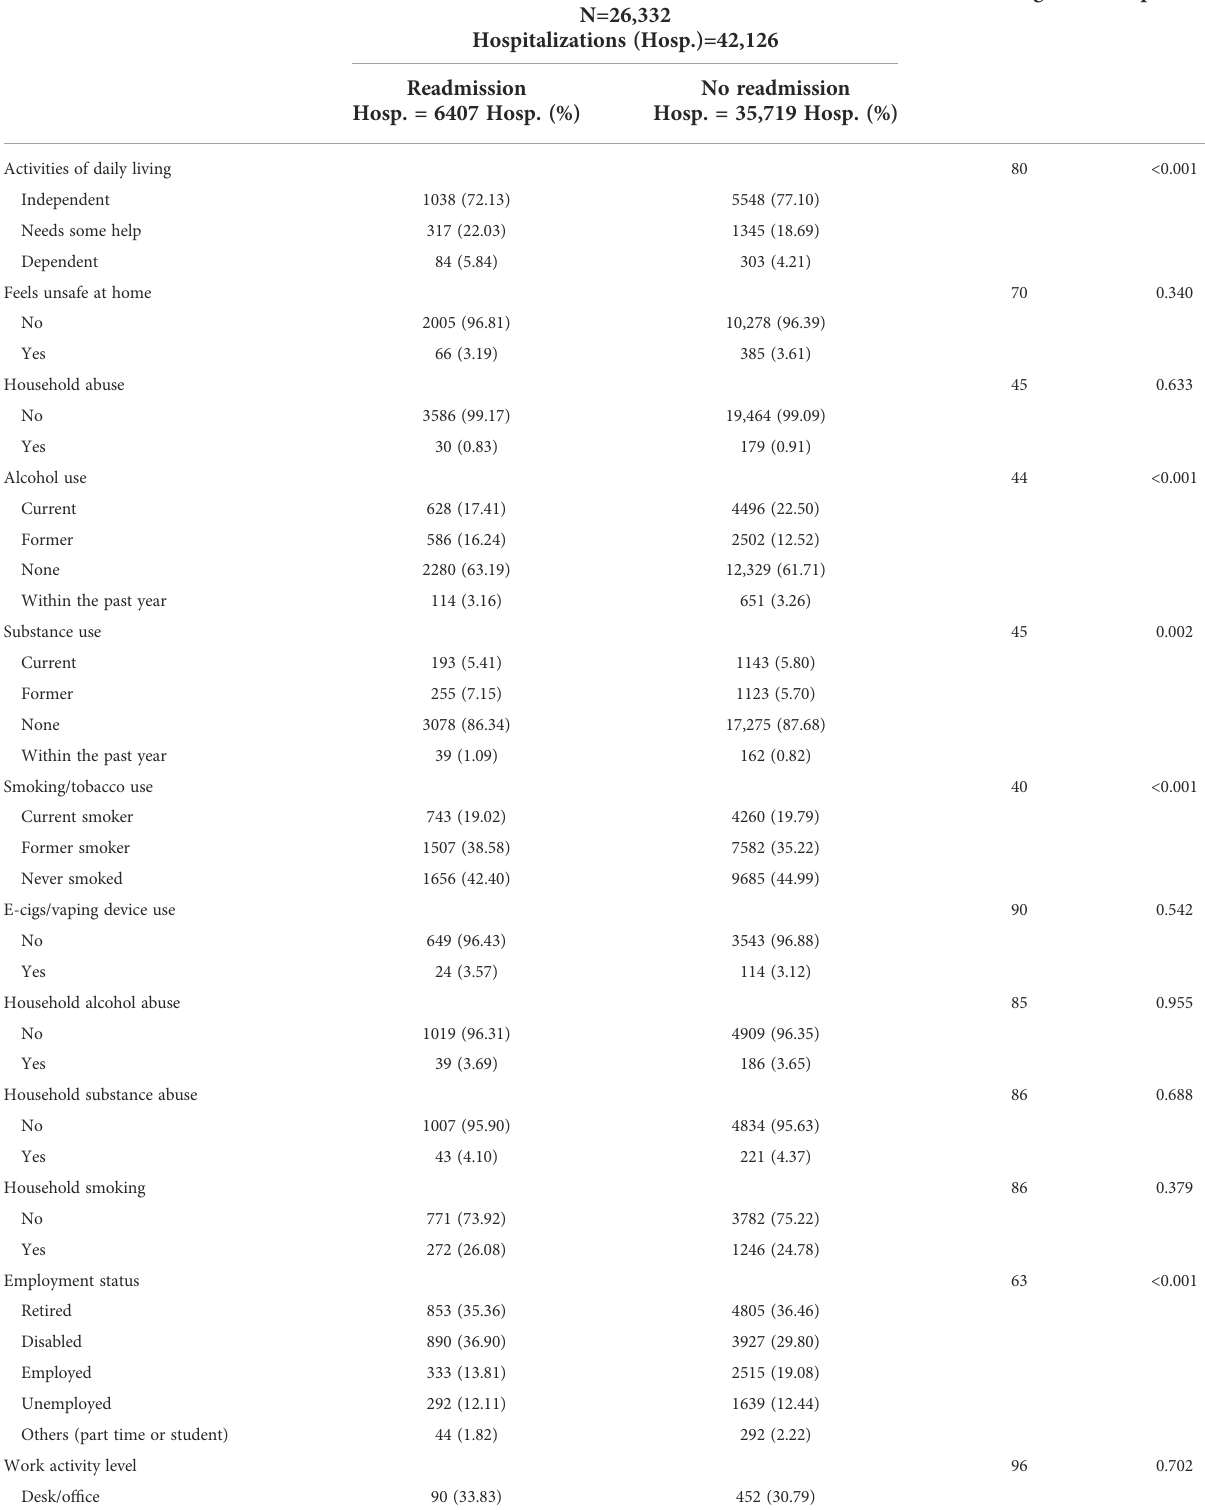
TABLE 2 Social needs of index